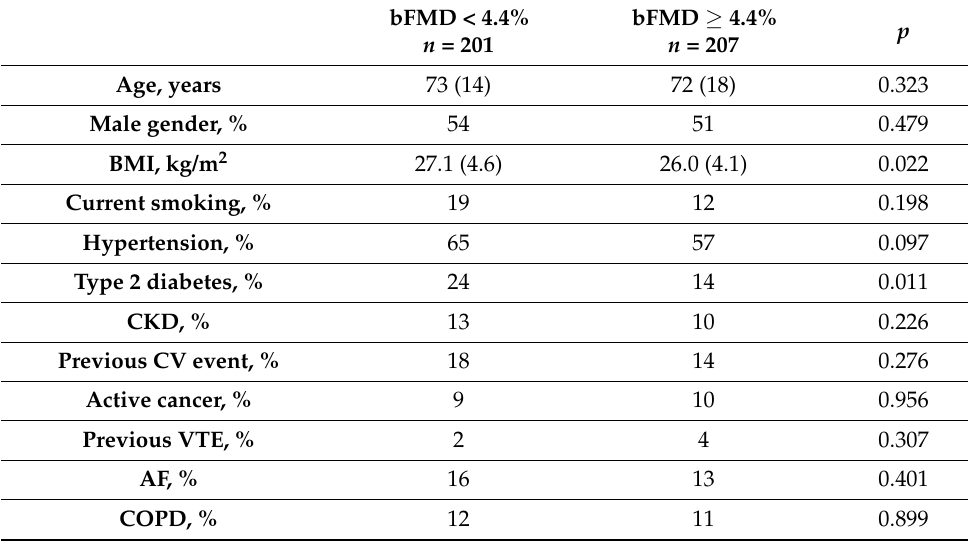
Table 2. Baseline characteristics of the study population according to low bFMD (bFMD < 4.4%) versus high bFMD (bFMD ≥